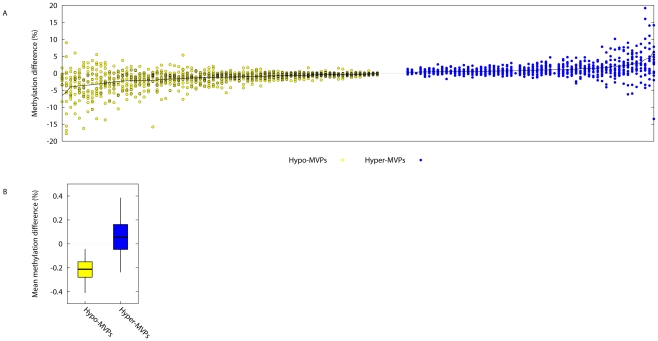
Identification of Type 1 Diabetes-associated DNA methylation variable positions (T1D–MVPs).(A) On the x-axis, each ‘column’ of data contains 15 different points, indicating the absolute intra-pair DNA methylation difference observed at a single T1D–MVP for each of the 15 different T1D–discordant MZ pairs. Plotted are the 58 different hyper- and 74 different hypoT1D–MVPs that were called at P<0.01. Data are arranged in order of decreasing or increasing absolute intra-MZ pair methylation differences for hypo- (yellow) and hyper- (blue) T1D–MVPs respectively (Refer to Table S2 for numerical values). (B) For each T1D–MVP, we asked whether experimental data is available for a neighboring CpG site within 2 kb genomic distance. In cases where several such CpG sites were present, we considered only the closest neighbor. These data were available for 56 Hypo-T1D–MVPs (out of total 74) and for 39 Hyper-T1D–MVPs (out of total 58). We then quantified the T1D–specific methylation change of these neighboring CpG sites, and plotted the intervals, such that boxes cover 50% and whiskers 95% of the data range.